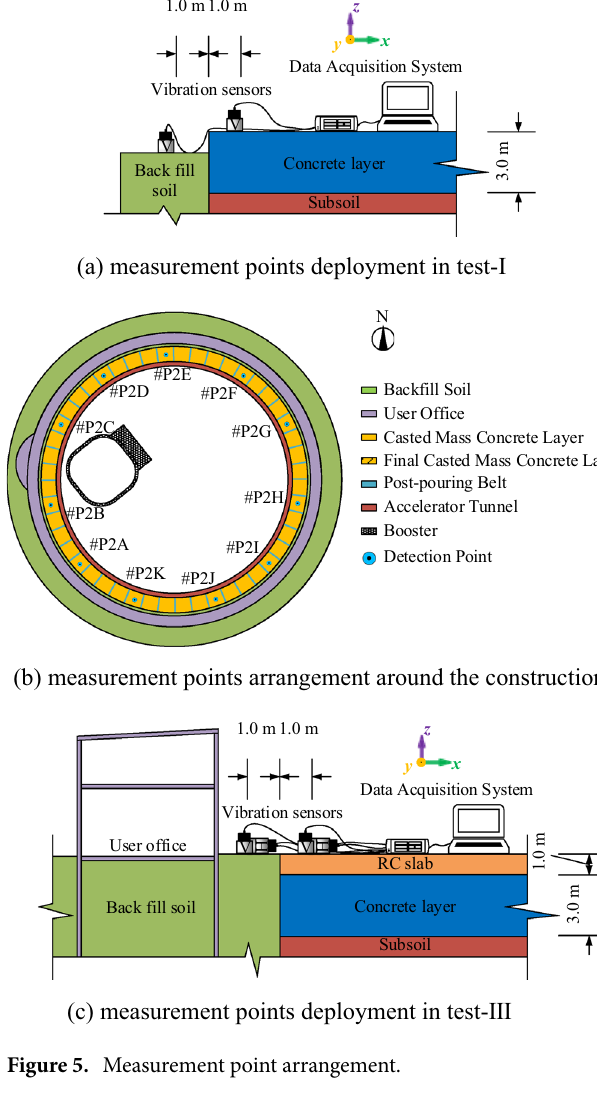
Figure 5. Measurement point